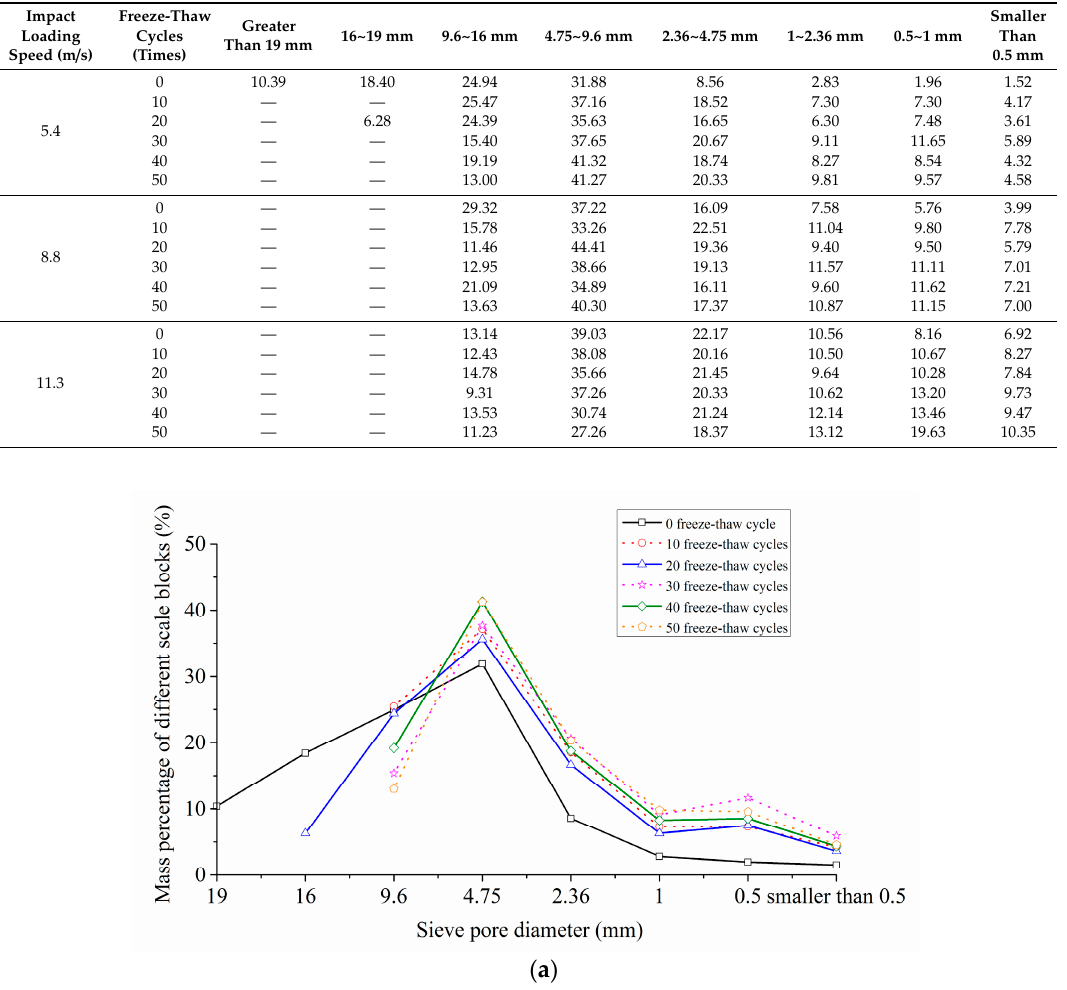
Table 5. Mass percentage of each particle size under di ff erent conditions.